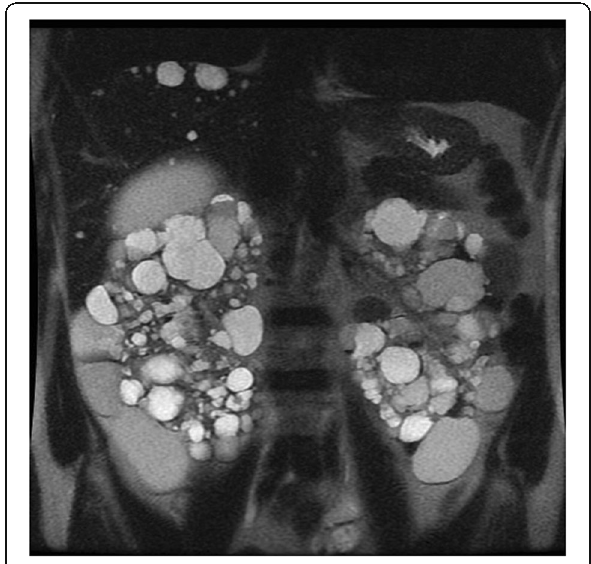
Fig. 11 Autosomal dominant polycystic kidney disease. Coronal T2- weighted image shows symmetric enlargement of the kidneys, which contain multiple cysts with variable size